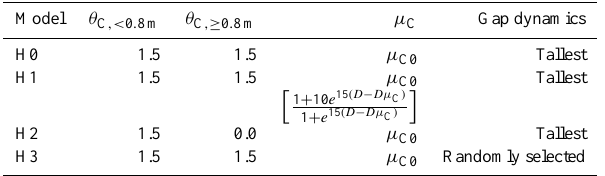
Table 2. Parameters for alternative assumptions regarding crown area allometry and mortality of large trees, as well as gap dynamics (canopy-space-filling). Model H0 is the baseline LM3-PPA model, and H1–H3 are alternative